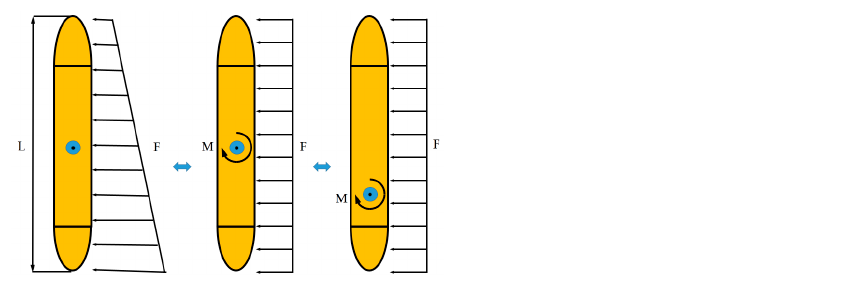
( c ) Figure 7. Three sets of experiments. The red arrow in the figure is the movement direction of the underwater robot and the white line is the axis of the force-and-torque-measuring device. ( a , b ) and ( c ) show the experiments in directions of surge, sway and yaw respectively. The experiment regarding the force in the direction of sway and the data of the artificial lateral-line system is conducted secondly. The bow direction of the underwater robot and the movement direction of the underwater robot are perpendicular. As with the previous experiment, the axis of the force-measuring device passes through the center of the underwater robot, as shown in Figure 7b. In this experiment, force is dominant, and torque is zero in theory. In the third set of experiments, the relationship between the torque in the direction of yaw and the data of the artificial lateral-line system is studied. The bow direction of the underwater robot is perpendicular with the movement direction. As shown in Figure 7c, the axis of the force-measuring device does not pass through the center of the underwater robot, which is kept at a distance. In this set of experiments, torque is the main object to be studied.